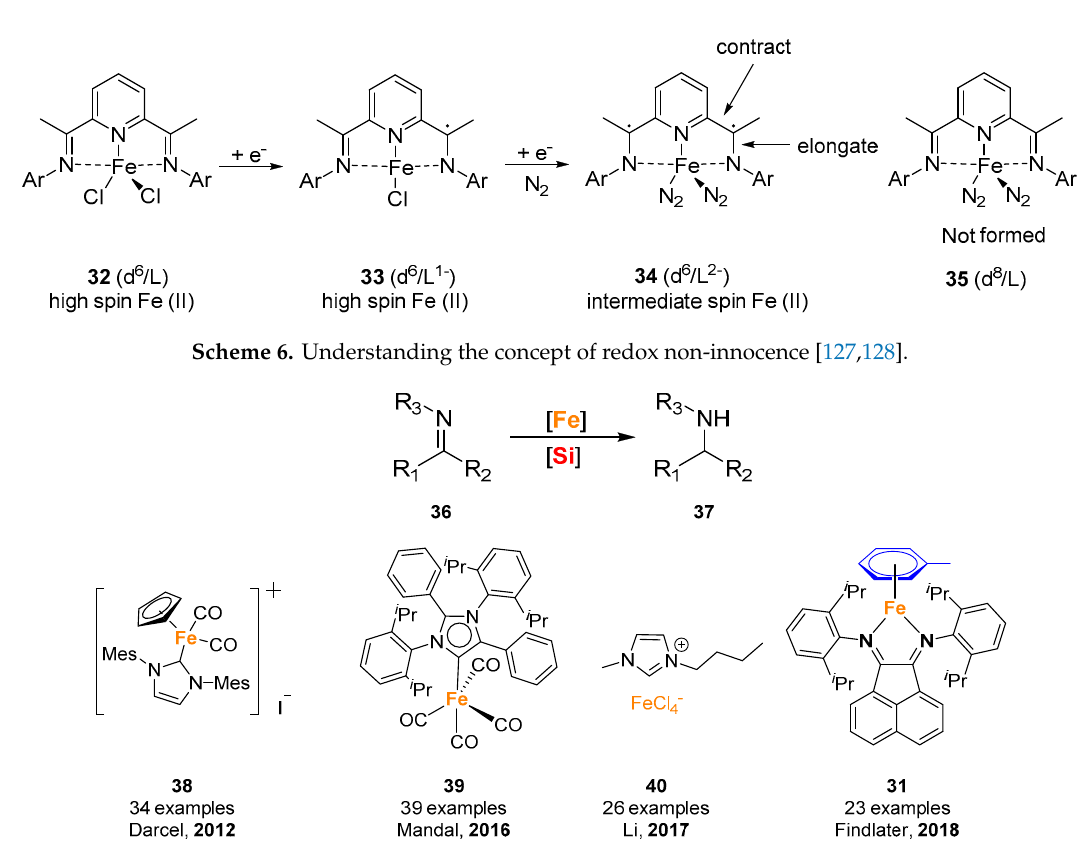
Scheme 7. Examples of iron-based catalysts in the hydrosilylation of imines.